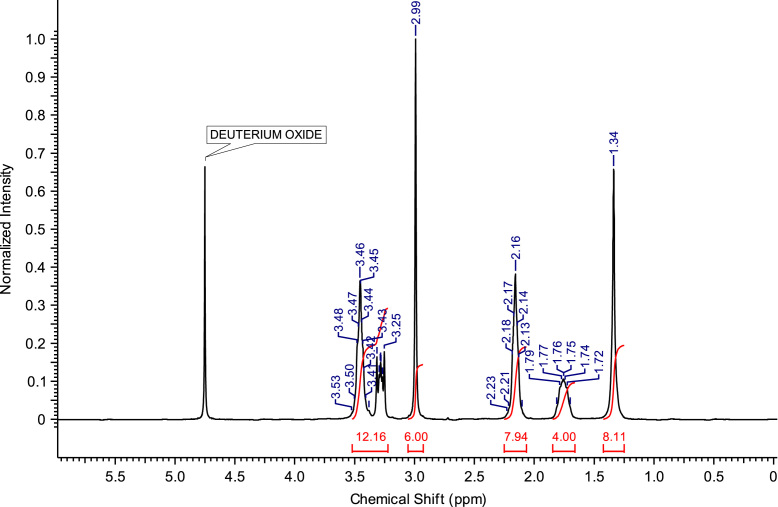
1H NMR spectra of C8(MPyrr)2Br2.